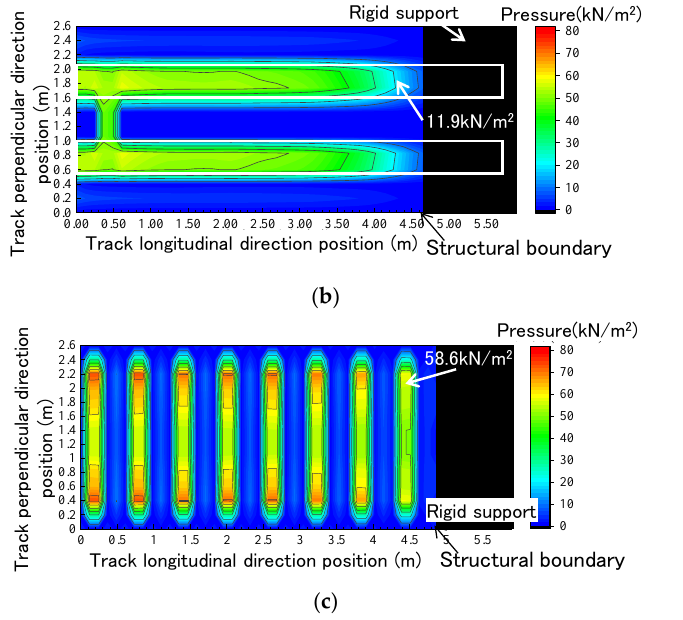
Figure 18. Distribution of the pressure on the sleeper bottom plane with “step - up” running (CASE3) : ( a ) ladder track (Support A); ( b ) ladder track (Support B); ( c ) PC sleeper track.